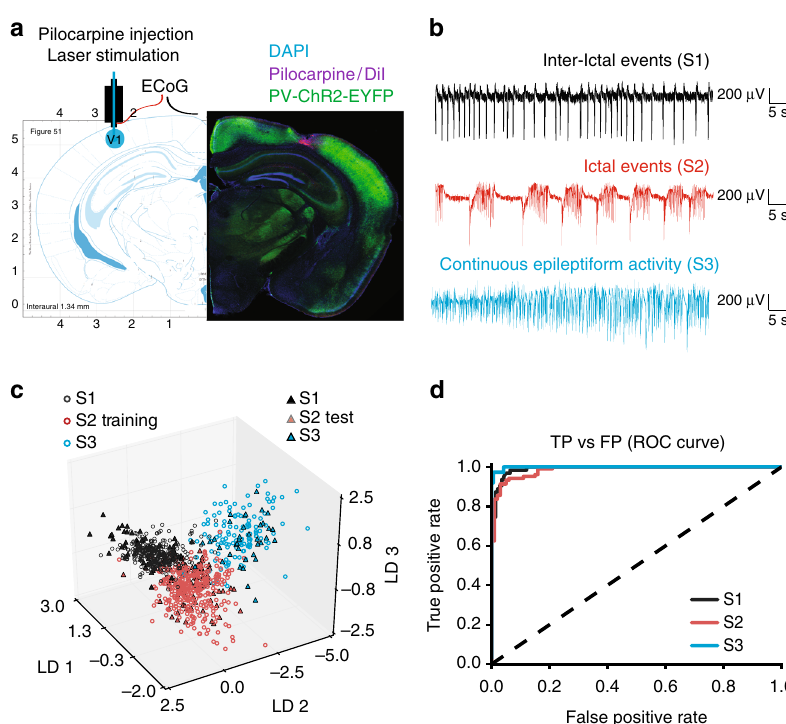
Fig. 1 Acute epileptiform activity induced by pilocarpine injections in the mouse visual cortex. a Left: diagram showing the cannula guide location over the site of pilocarpine injection, ElectroCorticoGram (ECoG) recording and photostimulation in the visual cortex V1 area. Right: immuno fl uorescence of PV + interneurons expressing ChR2-EYFP (green), cell nuclei staining DAPI (blue) and DiI co-injected with pilocarpine (magenta). Restricted DiI spread suggests that pilocarpine has a local action. b ECoG traces showing three different types of epileptiform activity induced by pilocarpine (States 1, 2, 3). c 3D plot of the linear discriminant analysis demonstrates network state separation on the training (open circles) and test ( fi lled triangles) ECoG samples. Each linear discriminant (LD1, LD2, LD3) corresponds to a particular combination of weights of the 20 features extracted from ECoG traces. d Performance of the random forest network state classi fi er expressed as a Receiver Operating Characteristic (ROC) curve. TP true positives, FP false positives. The dashed line shows random allocation of events. Source data are provided as a Source Data fi